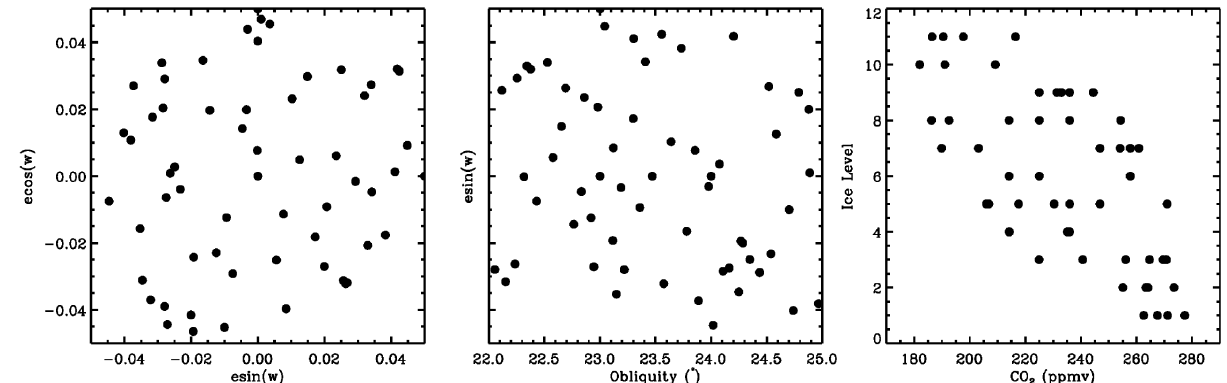
Figure 2. Experiment plan design, optimised to maximise the minimum distance between points and to achieve orthogonality (maximise the determinant of the covariance of input factors). Right: e cos (cid:36) – e sin (cid:36) space distribution; middle: e sin (cid:36) –obliquity space distribution; right: glaciation level–CO 2 space distribution.